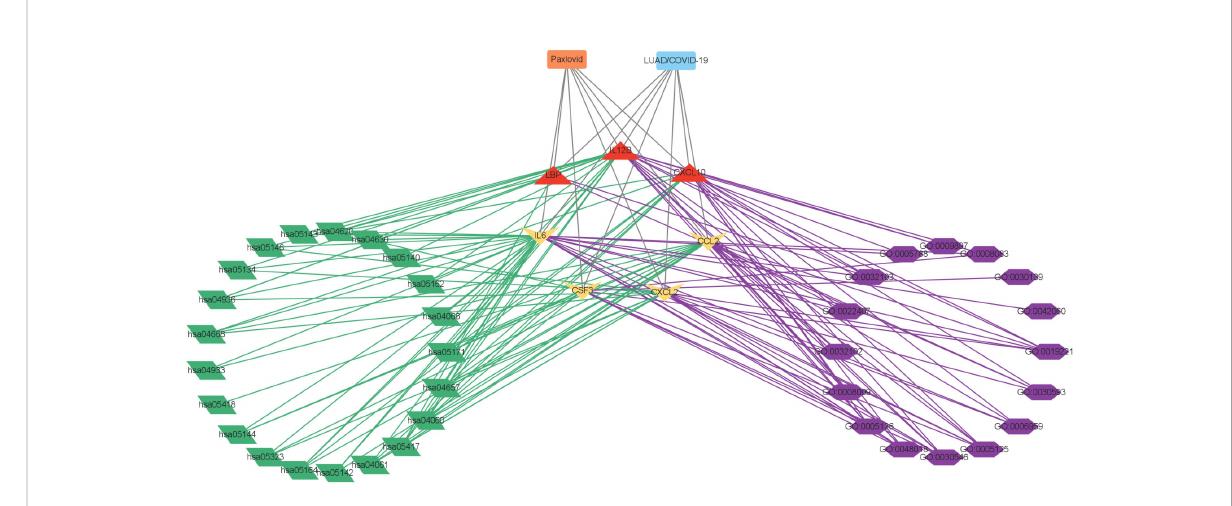
FIGURE 6 Interaction network showing core biotargets, pharmacological functions, and signaling pathways of Paxlovid against LUAD/COVID-19.